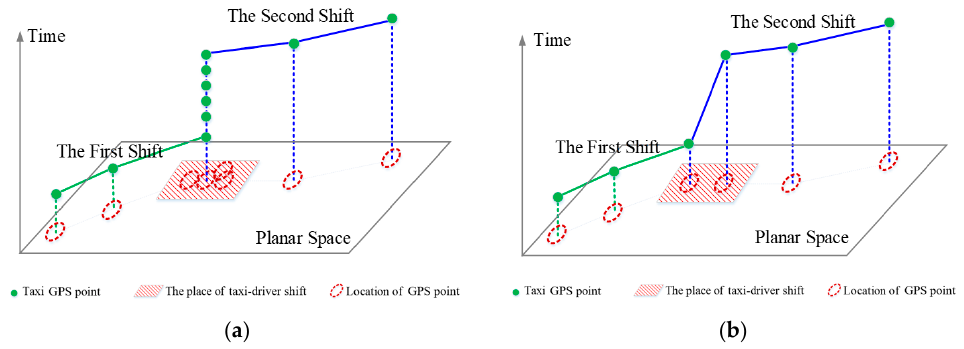
Figure 3. Taxi GPS data collection during taxi-driver shift activities: ( a ) the GPS data collection when the GPS device is on; ( b ) the GPS data collection when the GPS device is